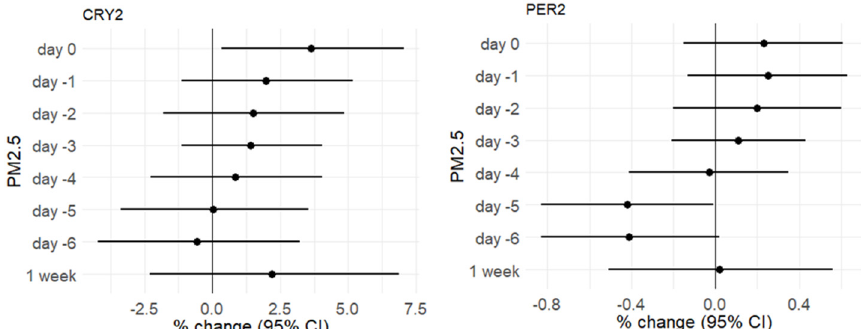
Figure 2. Plots showing the associations between short-term exposure to PM 10 and the methylation of CRY2 and PER2 genes from day 0 to day − 6. Methylation values are provided as percentage changes (% changes) in methylation associated with 10-µg/m 3 increments, estimated by multivariable regression models adjusted for age, BMI, smoking habits, percentage of lymphocytes, Pyrosequencing run, CpG site, season, temperature, and humidity.